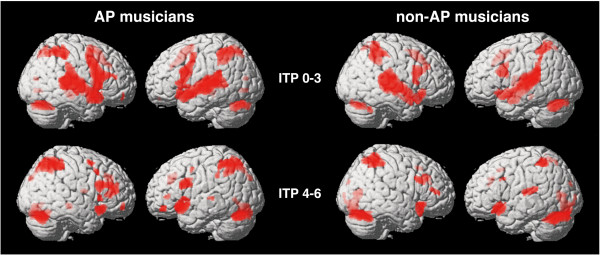
Activation patterns for AP and non-AP musicians. Contrasts are separated into early (ITP 0–3) and late (ITP 4–6) imaging time points (p < 0.001, uncorrected, voxel extent = 10) superimposed onto the surface reconstruction of a single, normalized brain.